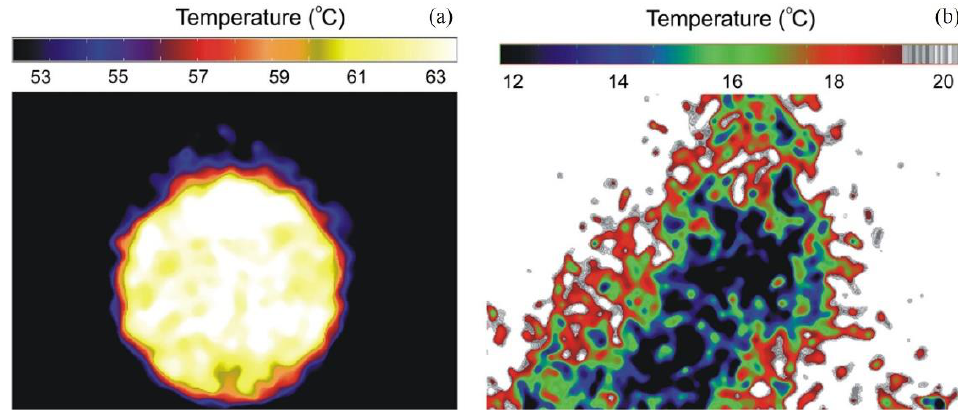
Figure 20. ( a ) Single-shot two-dimensional temperature measurement of a free-falling droplet; ( b ) single-shot water spray temperature measurement using thermographic phosphors [34]. Reprinted with permission from [34]. Elsevier, 2011.